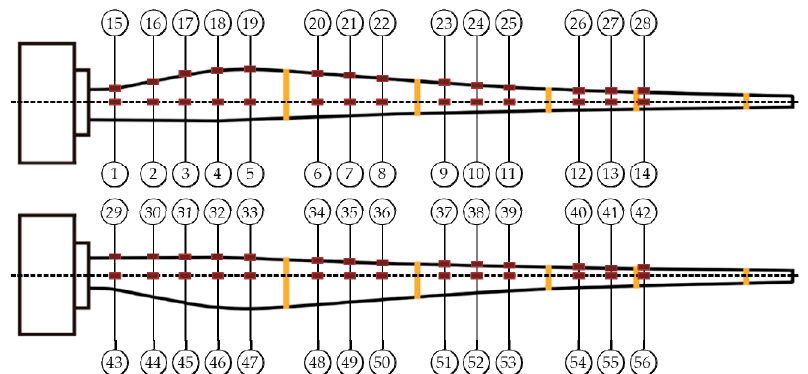
Figure 4. The locations and positions of strain gauges on the wind turbine blade.